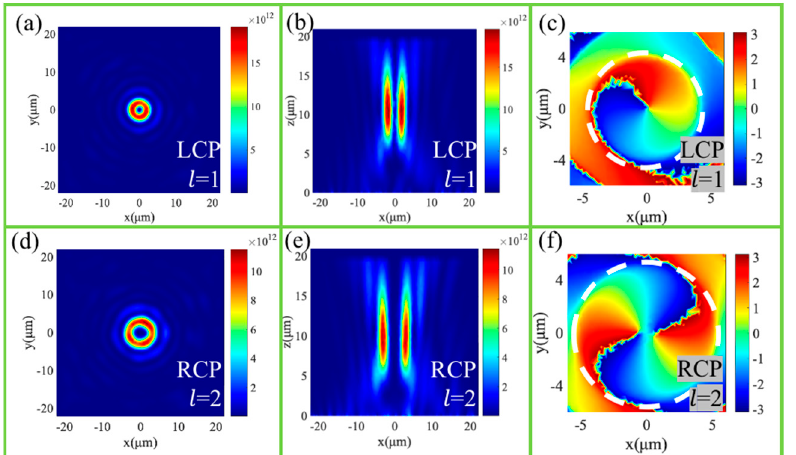
Figure 3. The intensity distributions of the vortex beam at the focusing plane under the LCP ( a ) and RCP ( d ) light illuminations. The intensity distributions of the converged vortex beam at the x-z plane under the LCP ( b ) and RCP ( e ) light illuminations. The phase distributions of the vortex beam at the focusing plane under the LCP ( c ) and RCP ( f ) light illuminations.